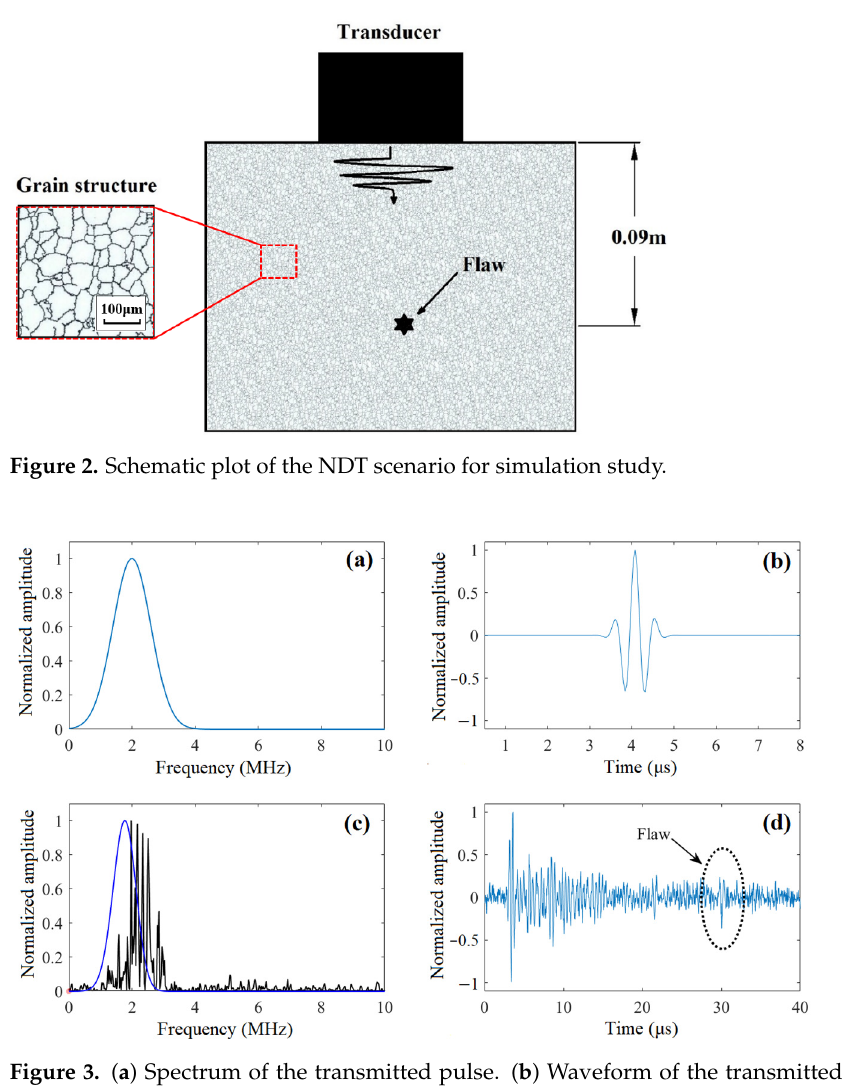
t = 30.56 μ s , revealing a depth of flaw of 91.7 mm. f